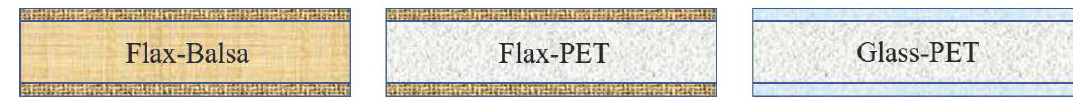
Figure 3. Schematic diagram of sandwich structures.